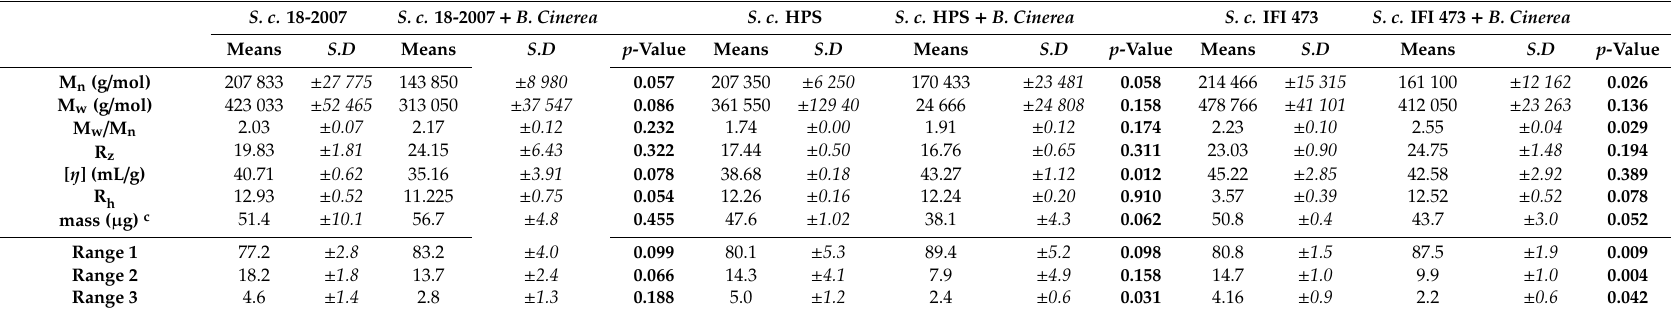
Table 2. Rheological parameters a and distribution analysis b determined by light scattering obtained for the macromolecules released by the three enological S. cerevisiae (S.c.) strains 18-2007, HPS, and IFI473, with or without B. cinerea culture.